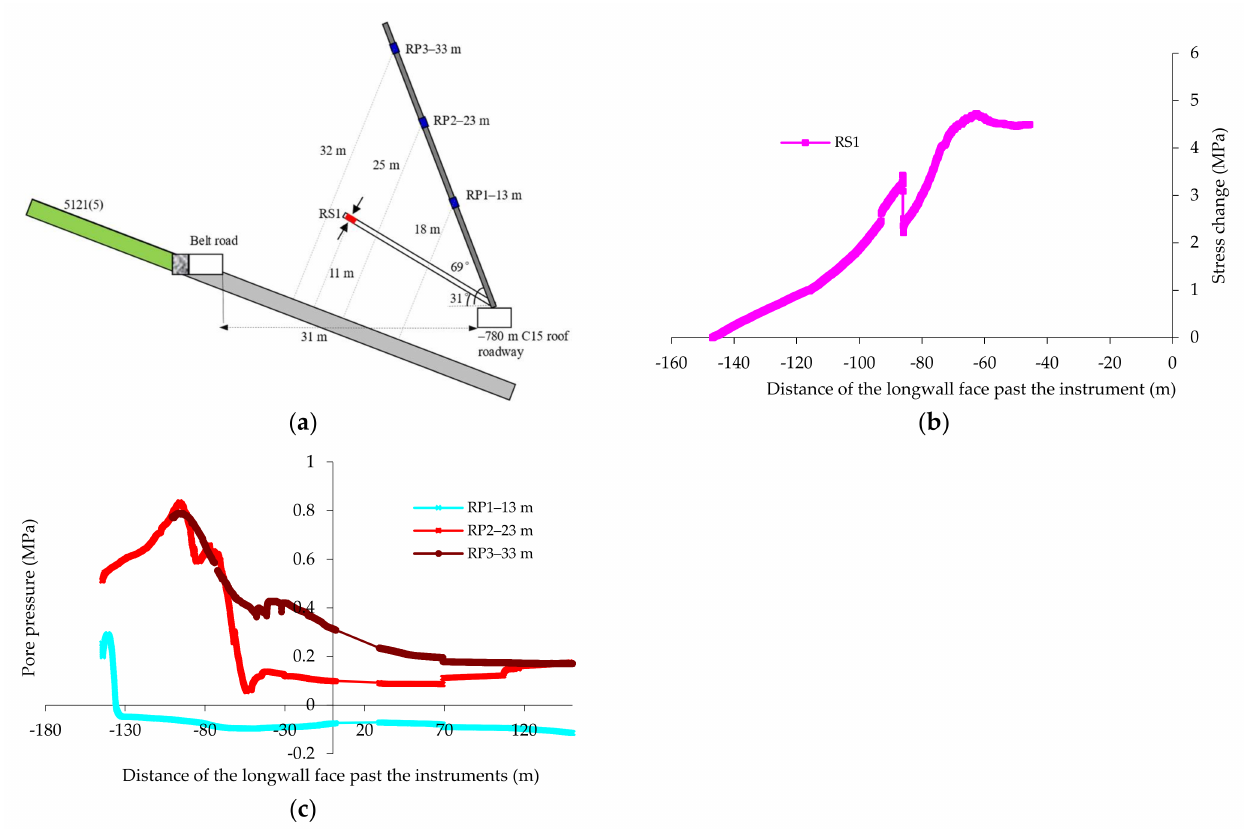
Figure 4. Recorded results from the roof roadway above LW 5121(5): ( a ) the locations of the instru- ments; ( b ) monitored roof stress change; ( c ) monitored pore pressure